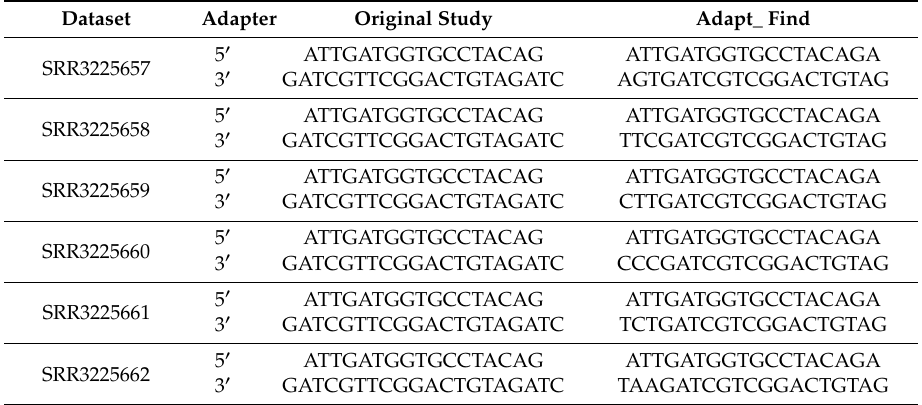
Table 2. adapt_find corrects the source information on adapter sequences. The discrepancies between the 3 (cid:48) end adapter sequence provided in the original study and the sequences predicted by adapt_find were manually inspected. The “grep” command revealed the frequent presence of the adapters identified by adapt_find in the raw sequencing files, while the sequence given in the source study was not found in the sequencing dataset. Also, adapter trimming using the parameters specified in the original study with the use of cutadapt was not